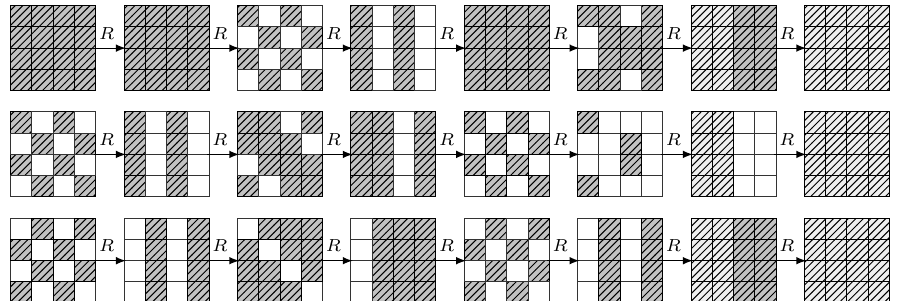
Figure 5: 7-round differential trails starting with ∆ x ,∆ x 0 and ∆ x ⊕ ∆ x 0 respectively. A white cell indicates that the state difference is zero for that bytes. Both darker and lighter line pattern cell indicate that the state difference is non-zero in the cell while darker one also indicates the value of difference in a cell equal to the value of one of other two differences in the same